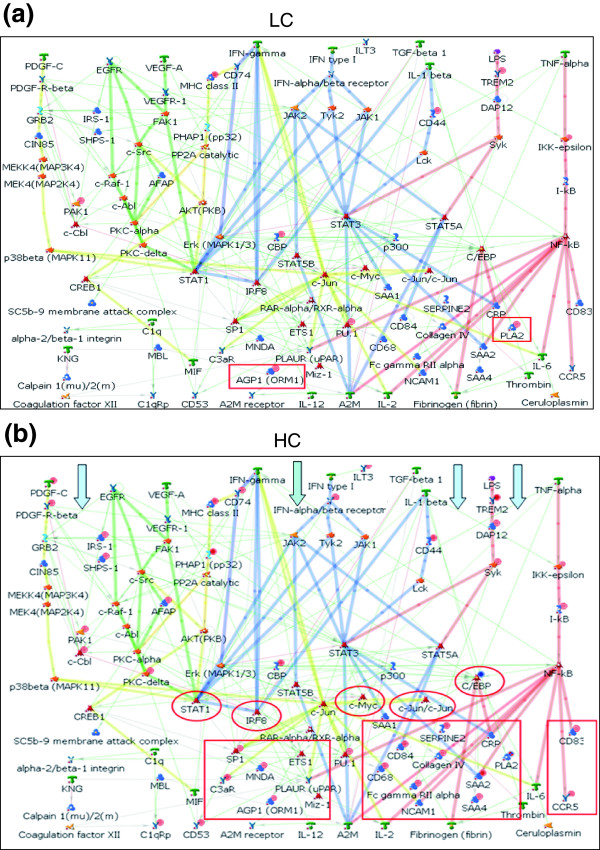
Analysis of the inflammatory pathways activated by the LC and HC diets. A master inflammatory network was generated in MetaCore™ by combining relevant inflammatory pathways. Differentially expressed genes in response to (a) LC and (b) HC treatment were mapped into this master network. The activation of the network by LC treatment was minimal, whereas HC treatment resulted in a profound activation of specific proinflammatory pathways (marked with blue arrows). Red circles indicate transcriptional node points and red rectangles highlight representative downstream target genes that were up-regulated.